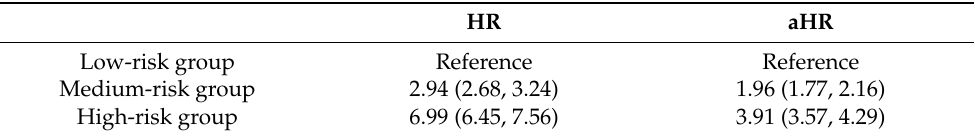
Table 2. Risk groups and risk of all-cause deaths among HD patients (Kanda E, et al. [12]). Medium- risk and high-risk groups (total score of 8 to 10 and 11 or more, respectively) showed a higher risk of all-cause death than the low-risk group (score: 0 to